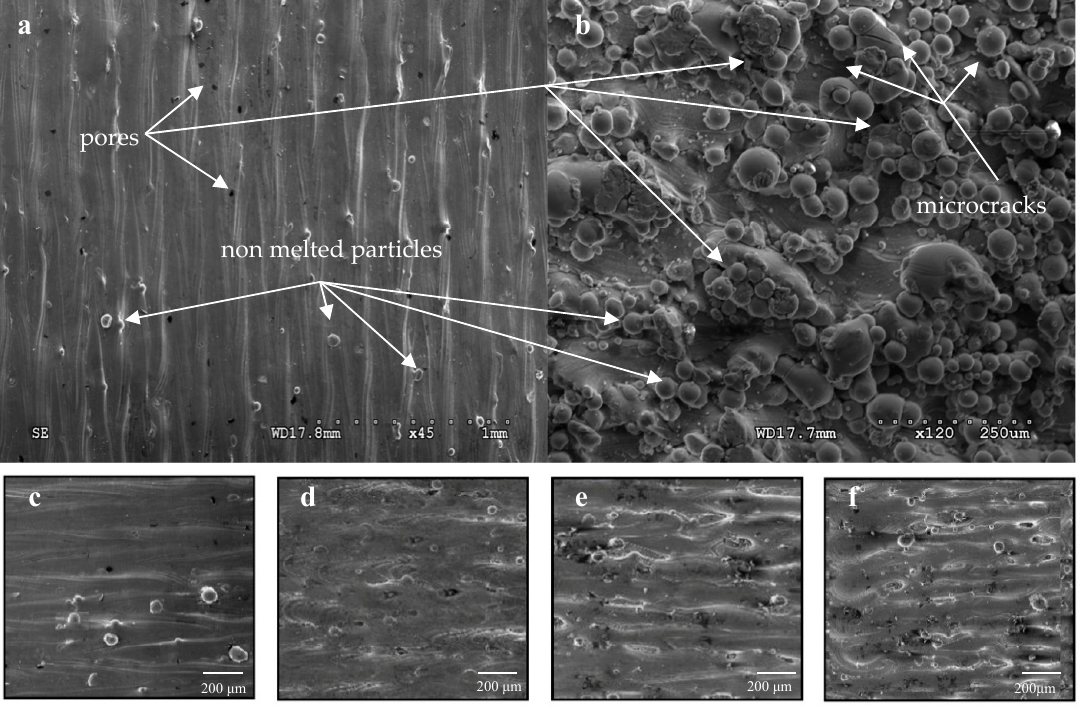
Figure 2. Top surface of a vertically built direction ( a ), lateral surface ( b ) and top surface of sample sintered with laser beam speed 300 mm/s ( c ), 500 mm/s ( d ), 1100 mm/s ( e ), 1300 mm/s ( f ).